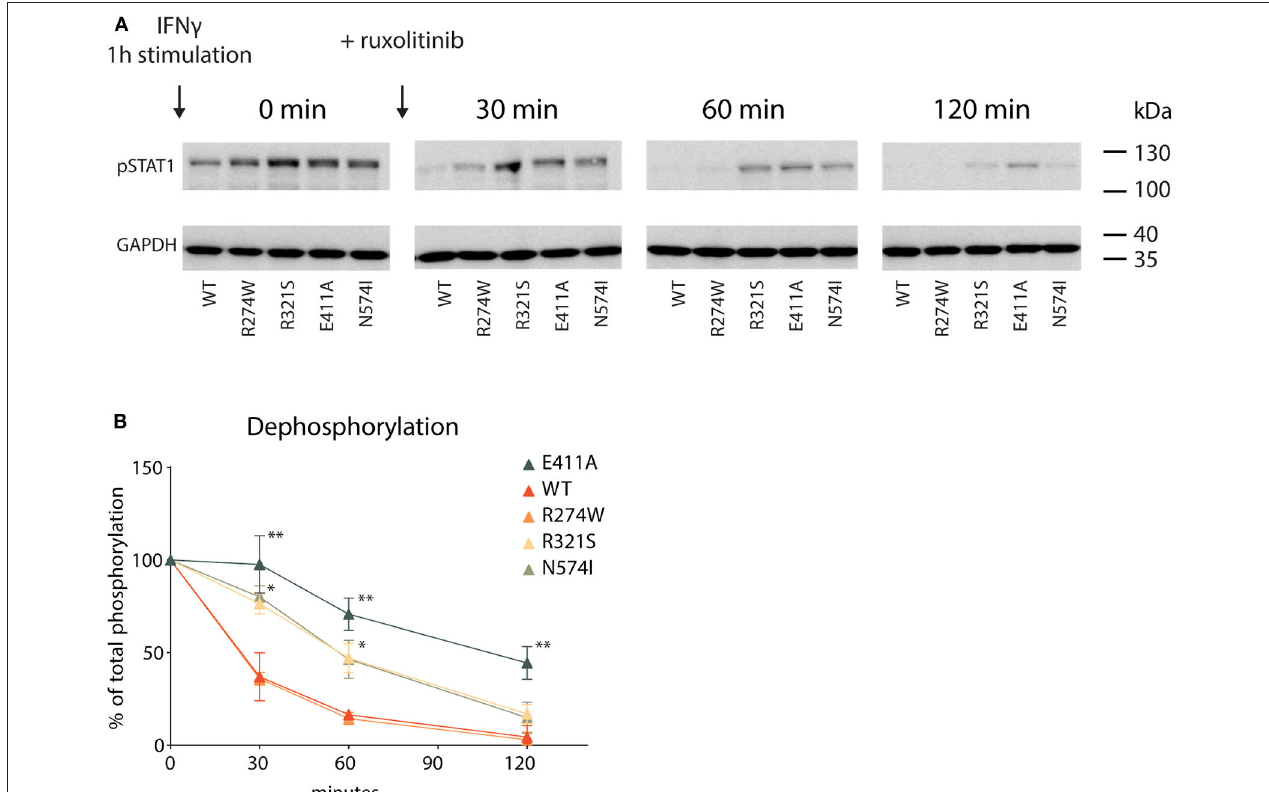
FIGURE 6 | Dephosphorylation kinetic (A) Representative Western blot of U3A cell lysates. Cells were first treated with IFN γ (1 U/ µ l) for 1h (minute 0) and then DMEM medium supplemented with ruxolitinib (10 µ M) was added. Whole cell lysate was collected 0, 30, 60, or 120min after ruxolitinib addition. (B) Quantification of pSTAT1 levels, plotted as % of maximum phosphorylation measured at minute 0. Statistical analysis: Student’s t -test, comparing every time point to the corresponding WT. * P < 0.05 ; ** P <